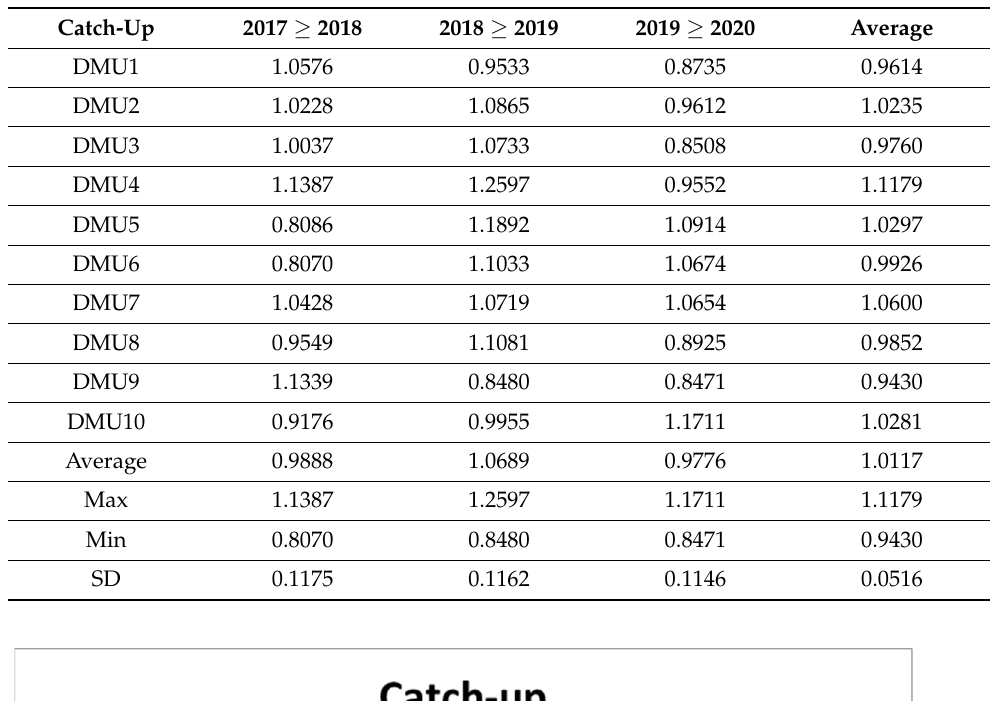
Table 7. Catch-up index of DMUs (2017–2020).